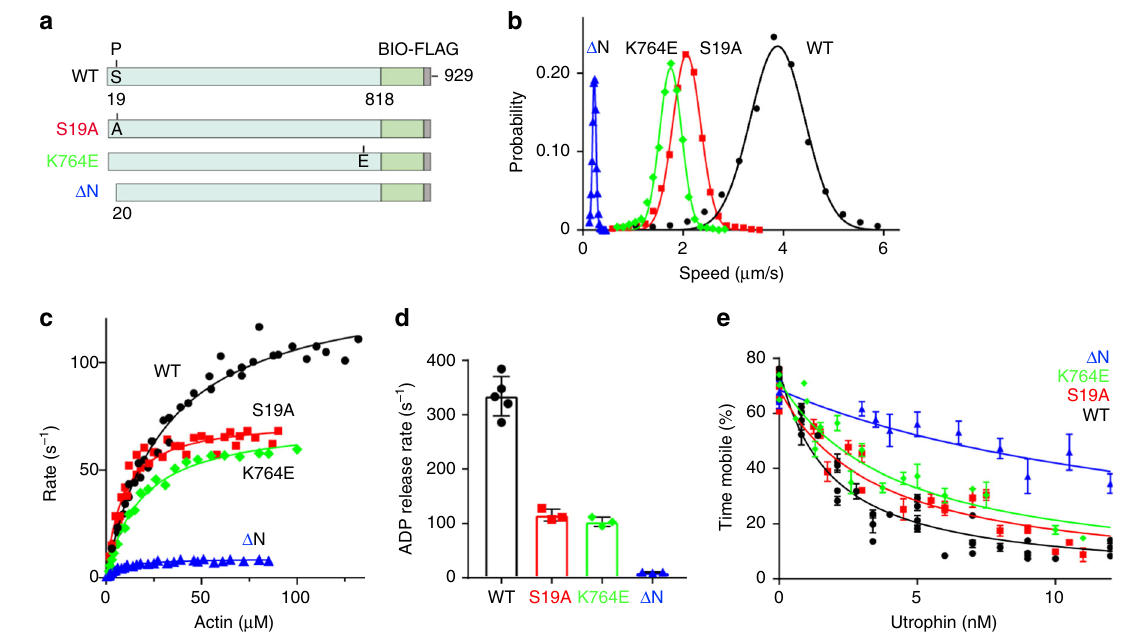
Fig. 5 Functional properties of wild-type (WT) and mutant full-length PfMyoA constructs. a Schematic of constructs used for functional analysis. Ser19 is fully phosphorylated during protein expression in Sf 9 cells (Supplementary Fig. 6). b Speed distributions from a representative in vitro motility assay.